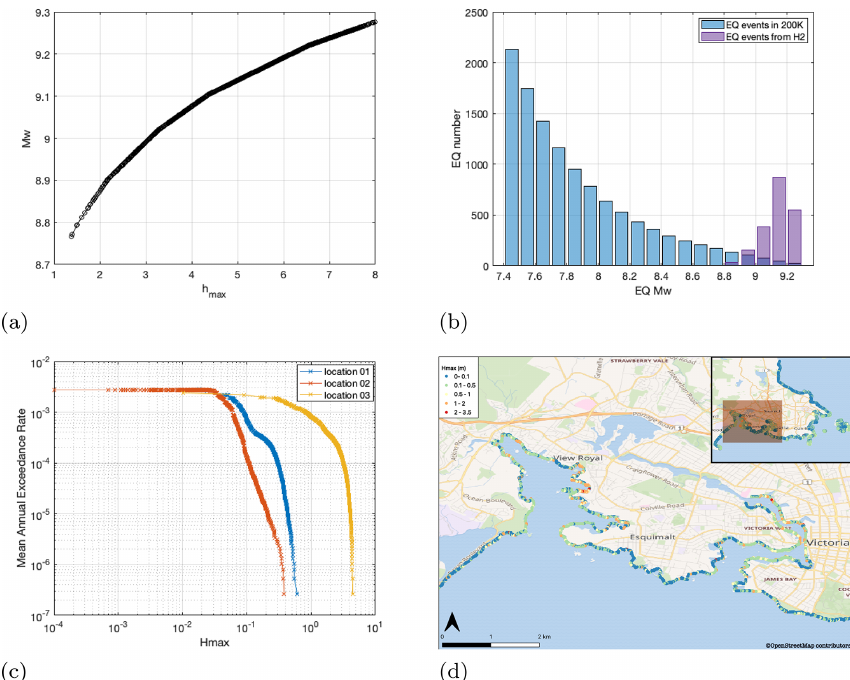
Figure 13. Panel (a) shows the relationship between earthquake magnitude ( M w ) and maximum uplift (hmax) when using a linear Okada solution for full rupture of the zone. Panel (d) shows the number of events per magnitude band following the tapered Gutenberg–Richter distribution for a 200000-year band (blue) and the H2 scenarios (purple). The sample hazard curves in (c) show the annual exceedance rates at three locations. The coastal hazard map in (d) shows the hazard values for the return period of 1000 years. Panel (d) was produced with the QGIS software using as base maps the Wikimedia layers with data provided by © OpenStreetMap contributors, 2021. Distributed under a Creative Commons BY-SA